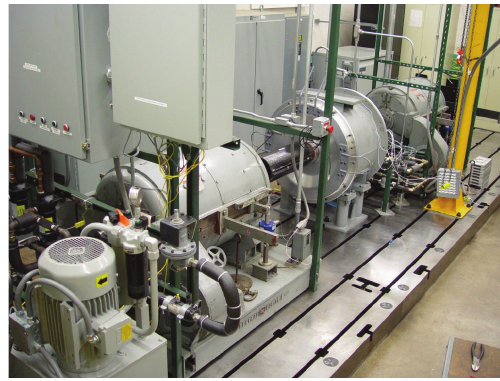
Figure 3: Torque converter dynamometer test cell, from left to right, hydraulic pump, input dynamometer, test fixture, and output dynamometer.